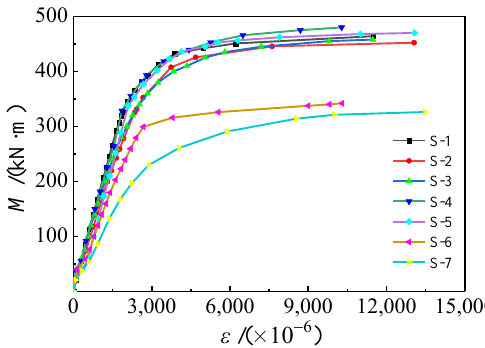
Figure 11. Moment versus bottom surface strain of specimens.